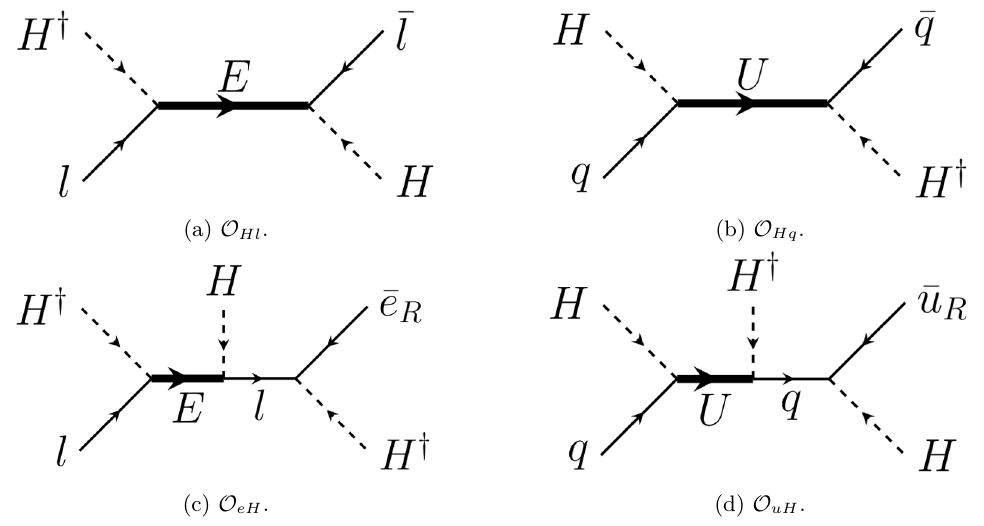
Figure 9. Diagrams for the operators O Hl , O Hq , O eH and O uH at tree-level. L and Q denote the SM lepton and quark doublet